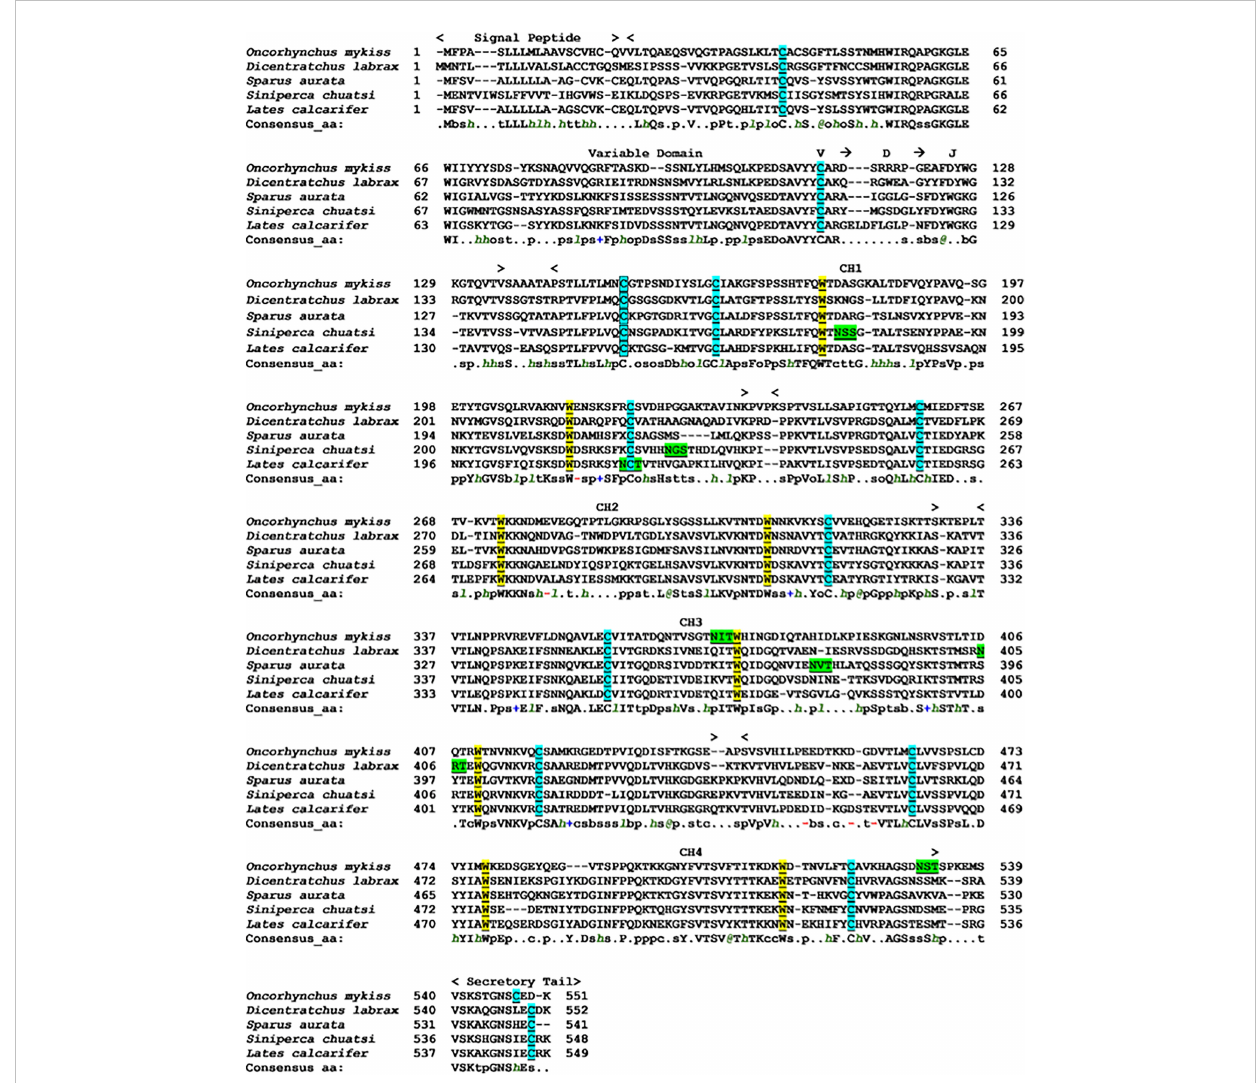
FIGURE 2 Alignment of Asian seabass secretory IgT heavy chain amino acid sequence with other known secretory IgT heavy chain fi sh species performed with PROMALS3D. The sequence was divided into predicted signal sequence, variable domain, predicted VDJ segment, four CH regions (CH1, CH2, CH3 and CH4) and C-terminal secretory tail are depicted above the sequences. The conserved cysteines residues that are underlined and highlighted in light blue are expected to form the intra-chain disul fi de bonds, while the cysteine residues in the black square box are expected to constitute the disul fi de bond to link the light chains to form the complete Ig molecule. The tryptophan residues were underlined and highlighted in yellow. Underlined and highlighted in green are the predicted N-glycosylation site. Consensus amino acid symbols are: conserved amino acids are in bold and uppercase letters; aliphatic (I, V, L): l ; aromatic (Y, H, W, F): @ ; hydrophobic (W, F, Y, M, L, I, V, A, C, T, H): h ; alcohol (S, T): o; polar residues (D, E, H, K, N, Q, R, S, T): p; tiny (A, G, C, S): t; small (A, G, C, S, V, N, D, T, P): s; bulky residues (E, F, I, K, L, M, Q, R, W, Y): b; positively charged (K, R, H): + ; negatively charged (D, E): -; charged (D, E, K, R, H):